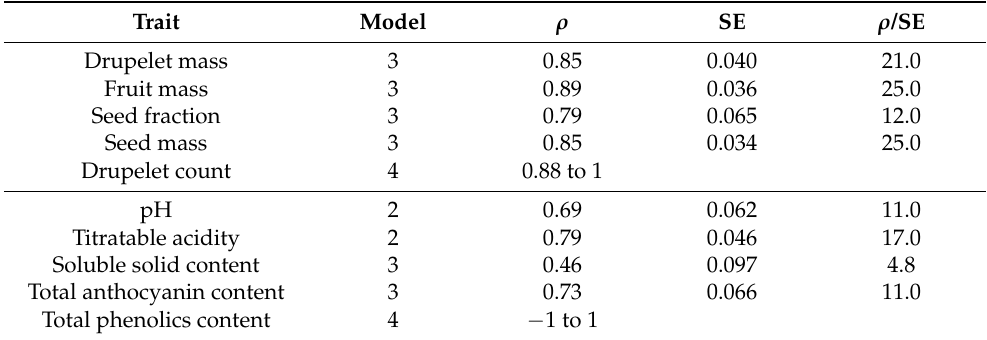
Table 3. Best fitting (co)variance structures and genome-by-environment correlation estimates ( ρ ) for black raspberry fruit quality traits tested in four locations (NC, NY, OH, and OR) and three years (2013, 2014, and 2015).